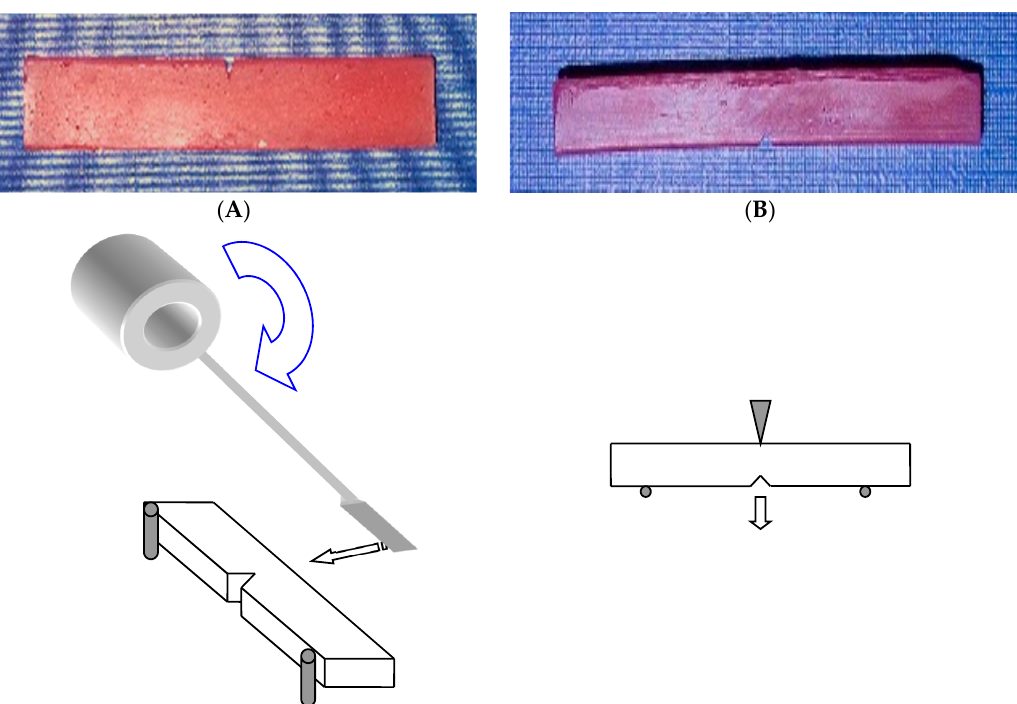
Figure 5. ( A ) Charpy impact test and specimen, ( B ) single-edge notch for fracture toughness test and